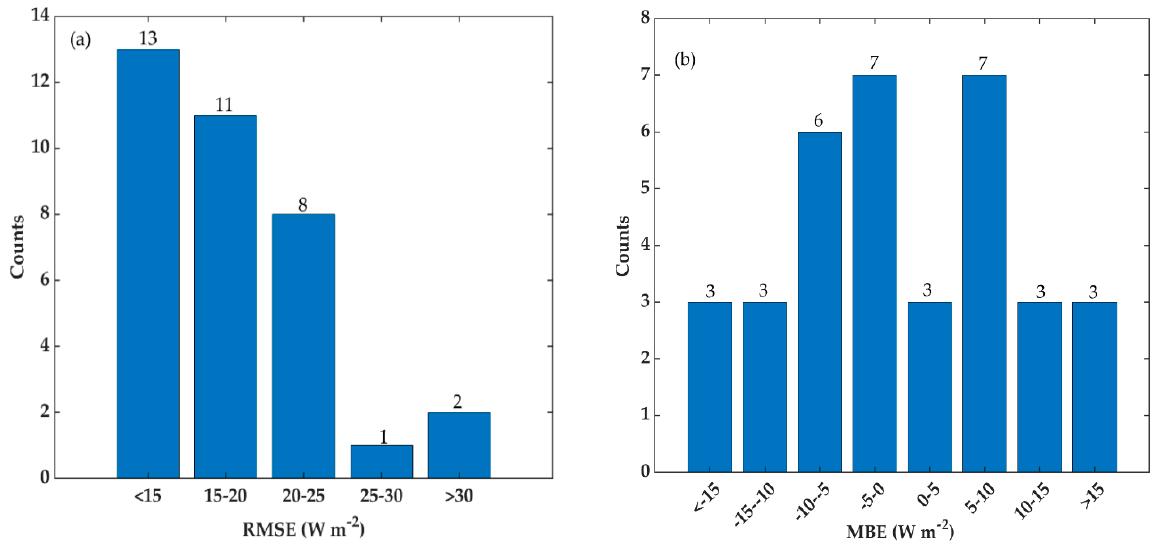
Figure 5. ( a ) RMSE and ( b ) MBE histograms of daily L d estimates with 5-km resolution based on the GBRT model against the ground measurements from March 2000 to December 2018.